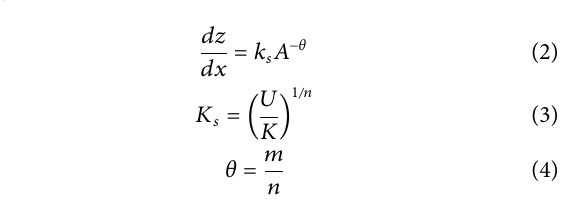
Frontiers in Earth Science |